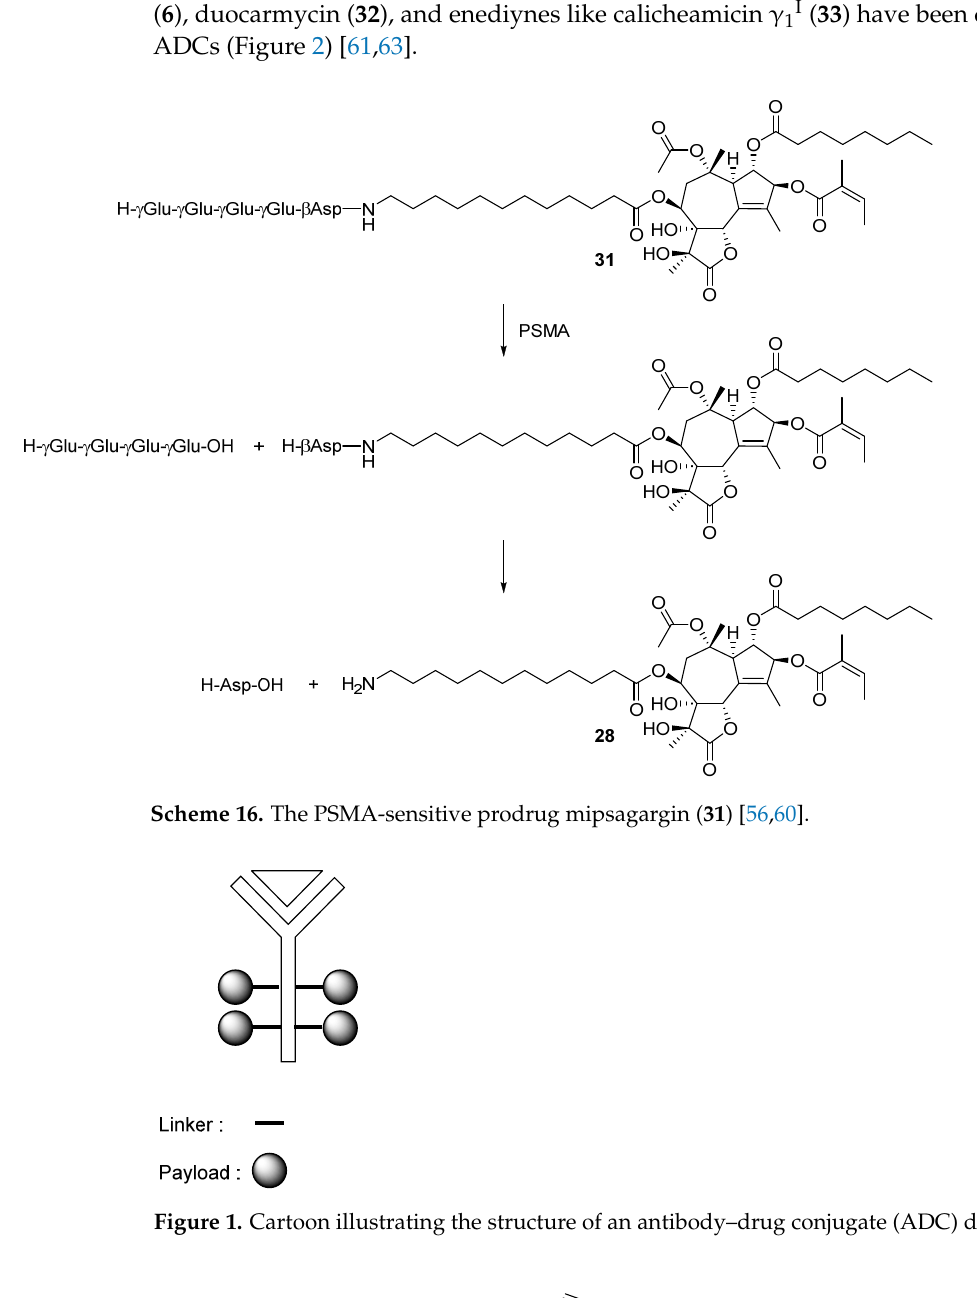
humans. The use of chimeric humanized antibodies has to some extent solved this prob- lem [65].